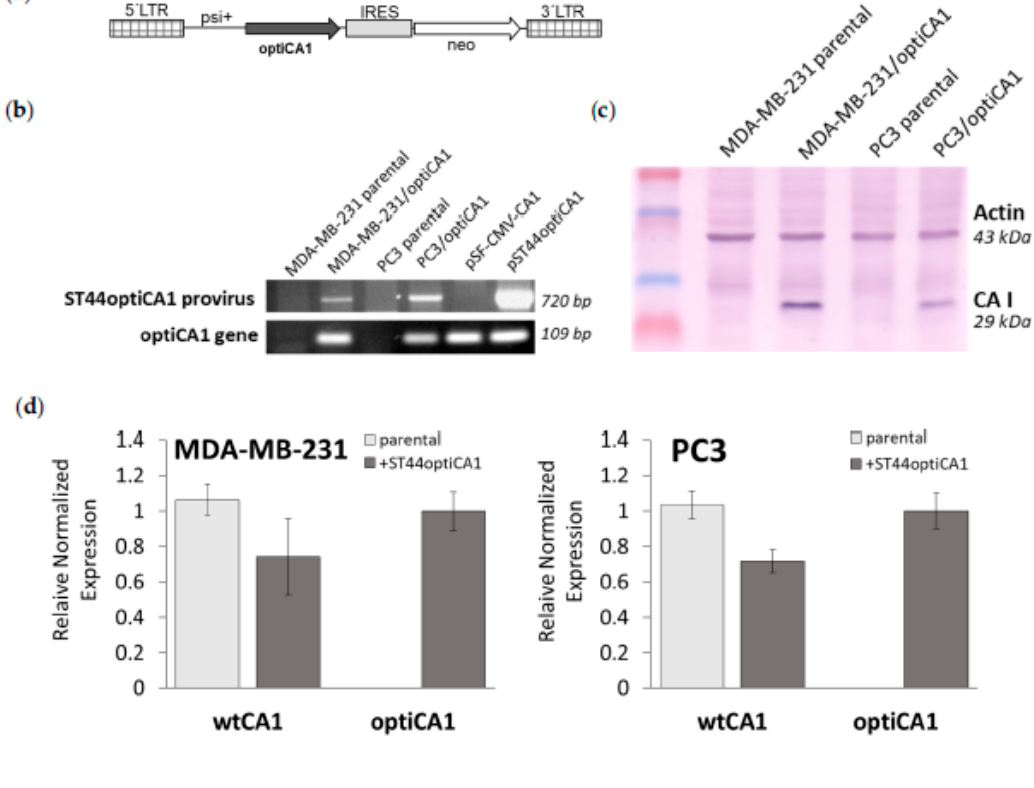
Figure 1. Genetically engineered tumor cells MDA-MB-231 and PC3 stable overexpress codon optimized human CA1 gene (optiCA1). ( a ) Structure of provirus ST44optiCA1. LTR, long